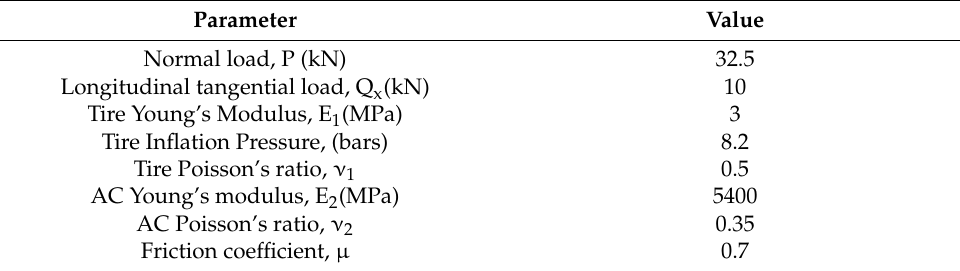
Table 1. Tire and pavement